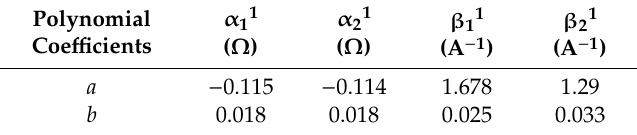
Table 10. Nonlinear parameters for MT1 pi-circuit as a function of soil